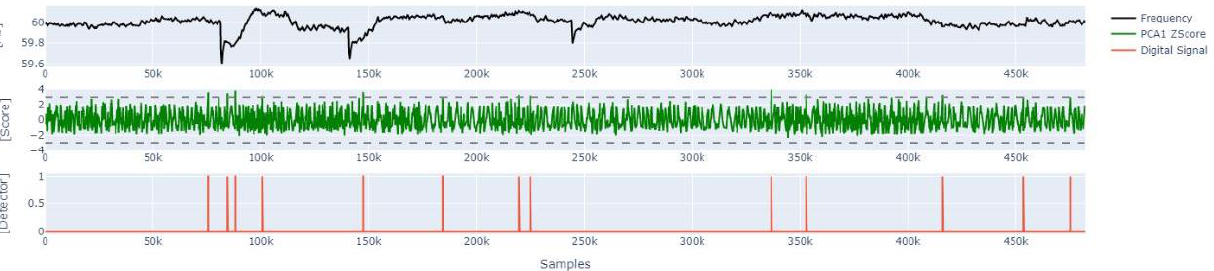
Figure 20. Event 2: detector event of PMU hydroelectric power station Ney Braga.